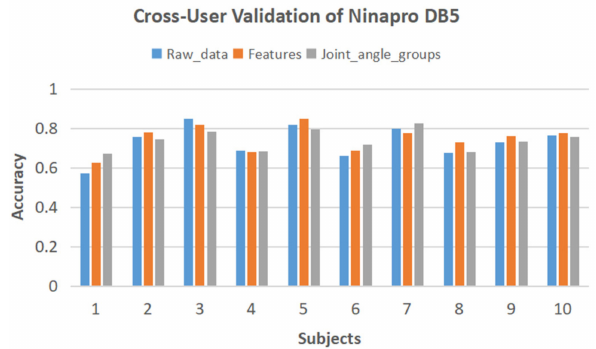
Figure 16. Cross-user validation results of Ninapro